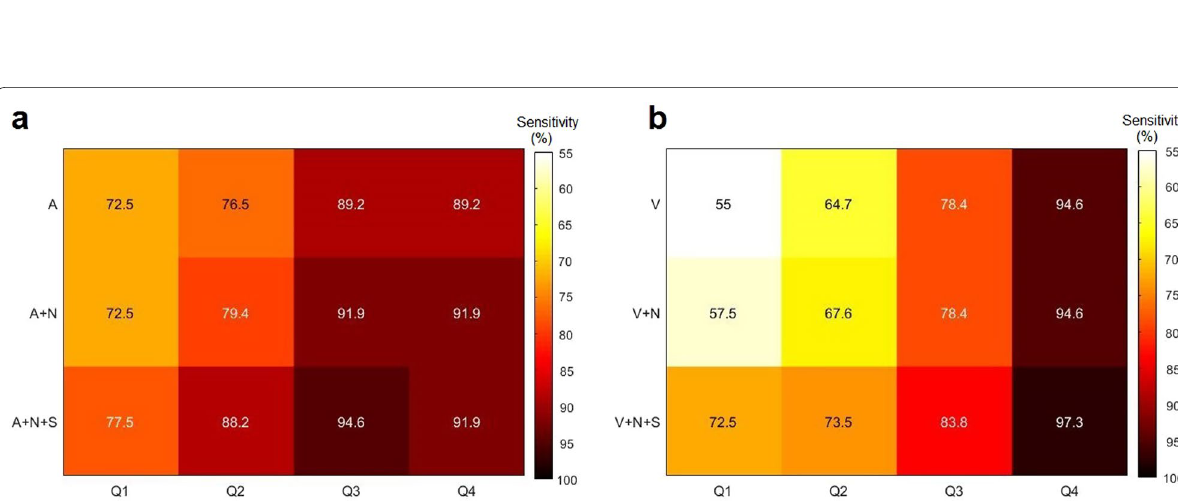
trast enhancing PTA but without Sestamibi uptake.